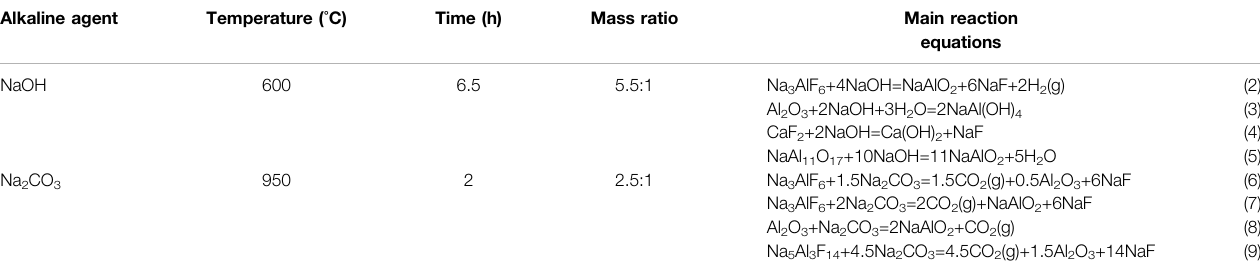
TABLE 3 | Optimum parameters for SCA treatment with different alkaline